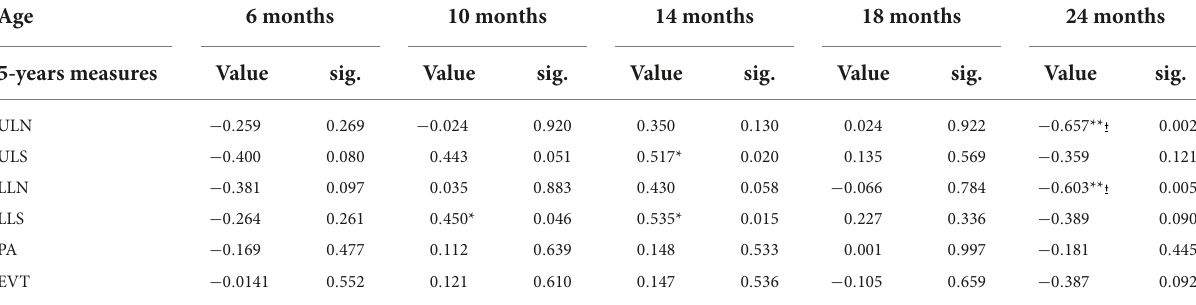
TABLE 8 Correlations between CS (child speech and speech-like vocalizations) at 6–24-months and reading-related measures at 5-years of age for the smaller sample of 20 participants with brain imaging data at